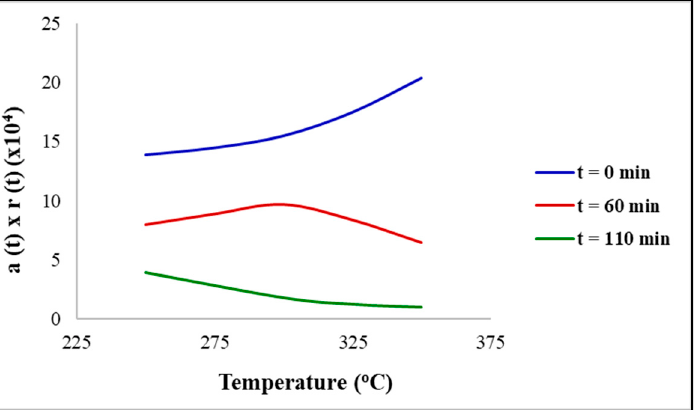
Figure 5. Reaction rate as a function of reaction temperature at varying times with catalyst = Ni/ZrO 2 . Reaction conditions: pressure = 30 bar, H 2 /oil ratio = 1000 and inlet liquid flow = 0.1 mL/min.